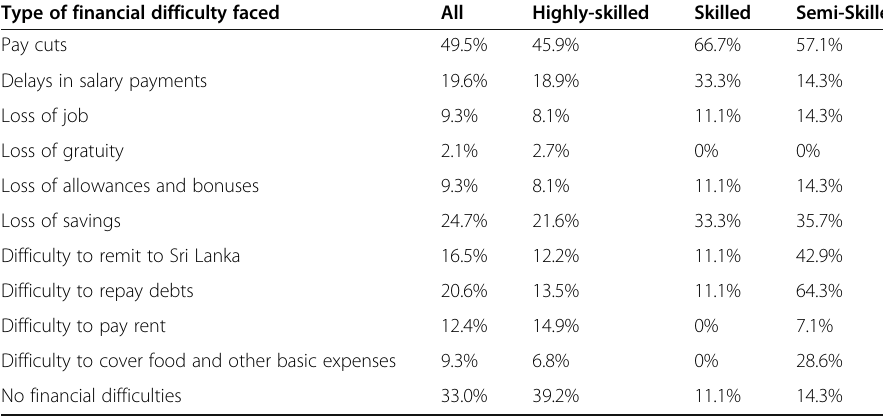
Table 1 Type of financial difficulties faced by Sri Lankan migrants in Qatar Type of financial difficulty faced All